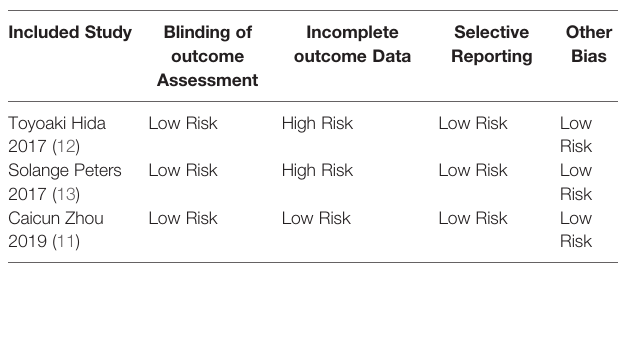
TABLE 5 | Risk of bias in included studies.